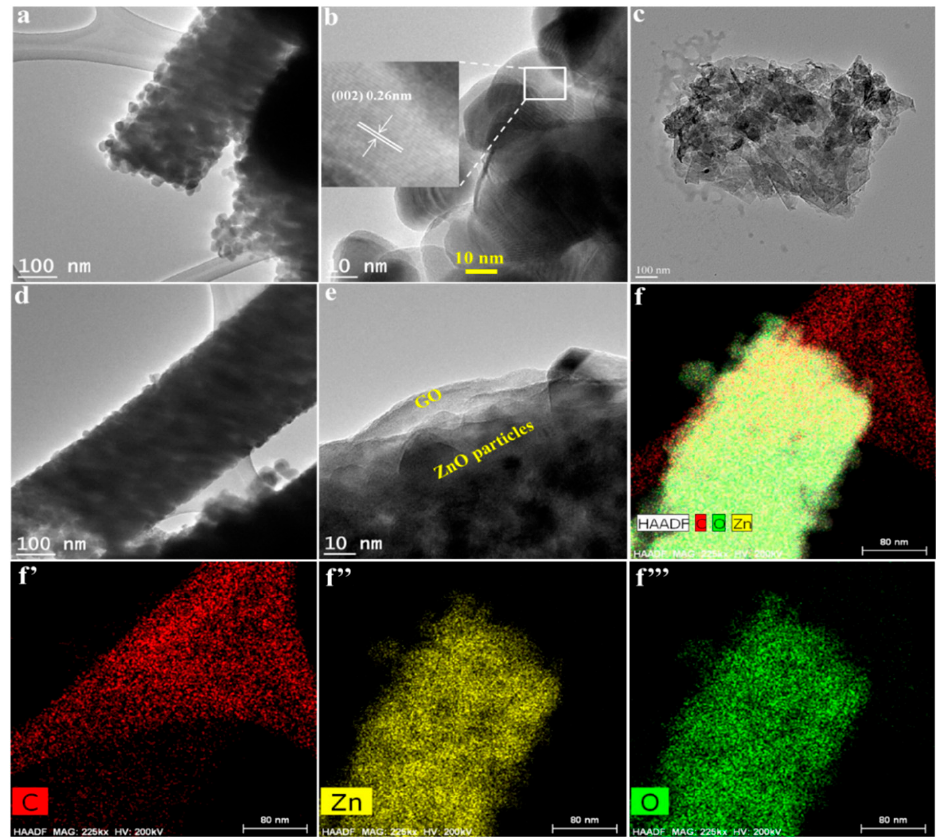
Figure 2. TEM images of ZnO NF ( a ); magnified image of ZnO particles on ZnO NF ( b ), GO ( c ), and ZnO@G CSNF ( d ); magnified image of ZnO@G CSNF ( e ); and elemental mapping images of ZnO@G CSNF ( f ): ( f’ ) C; ( f’’ ) Zn; ( f’’’ ) O.